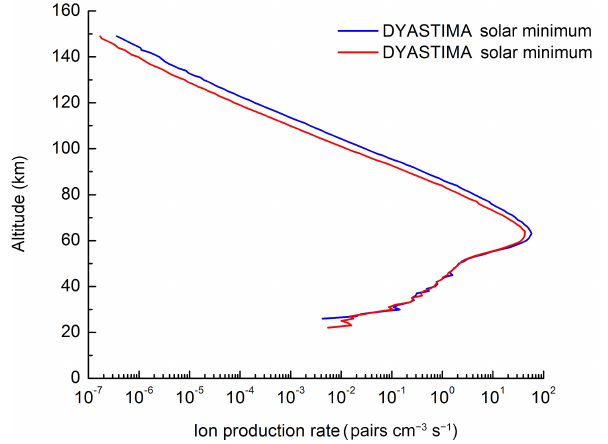
Figure 4. Ionization rate profiles in the Venusian atmosphere, as a function of altitude, derived with the DYASTIMA application for solar minimum conditions, in comparison with the estimates in other